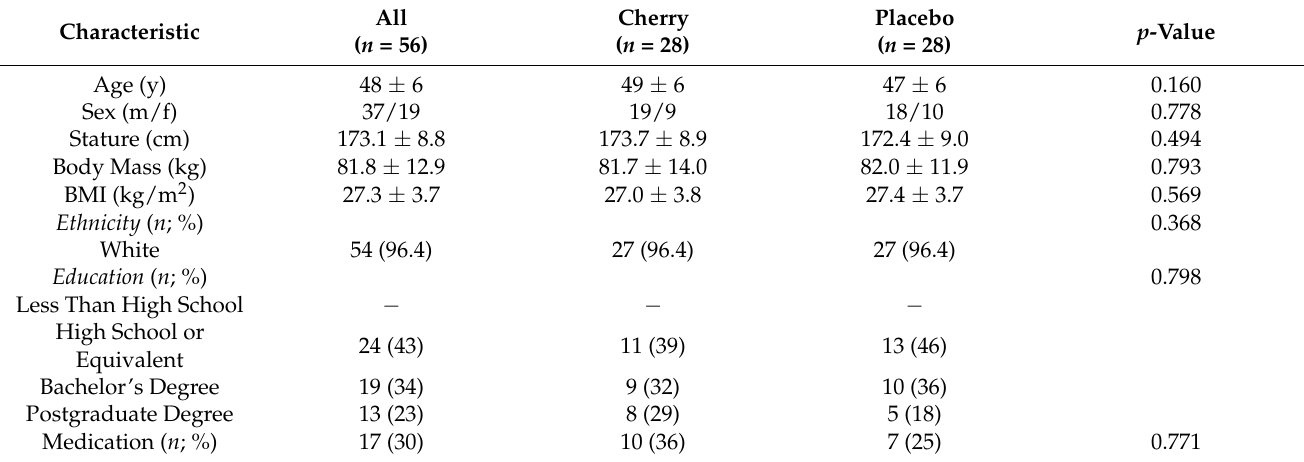
Figure 1. Consort flow diagram of participant enrolment and analysis in the study. Table 1. Baseline characteristics (Mean ± SD).